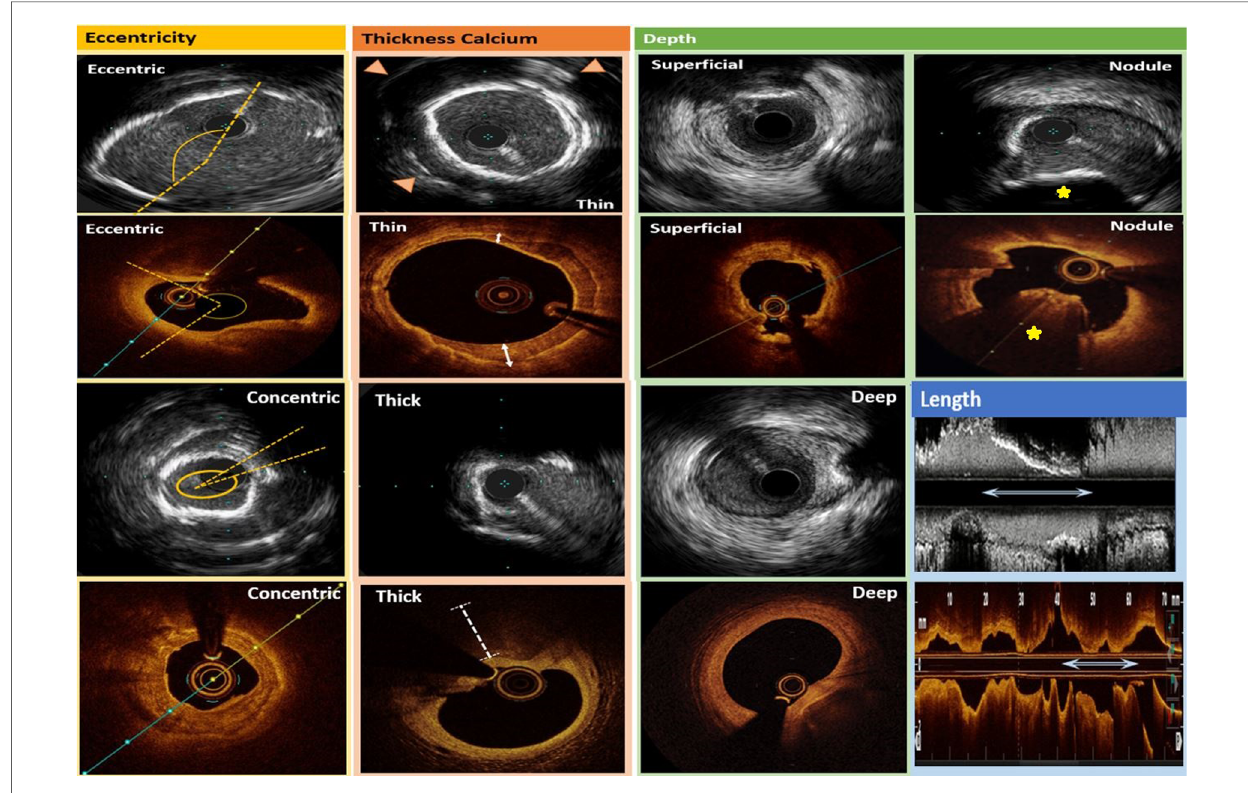
FIGURE 4 Intravascular ultrasound (rows 1 and 3) and optical coherence tomography (rows 2 and 4) calci fi cation pattern summary. In the fi rst column, calcium eccentricity is denoted by the dotted yellows lines which approximate the edges of the calci fi cation. In the second column, thin calcium on IVUS is denoted by the presence of reverberation artifact (arrowheads) whereas thick calcium shows signal drop-out beyond the calci fi cation. Also in the second column, thin calcium on OCT is demonstrated by the sharply delineated plaque with signal attenuation within its borders (bidirectional white arrows), and thick calcium on OCT is demonstrated by the white dotted line which shows signal drop-out beyond the calcium. In the third column, super fi cial and deep calcium intraluminal to the media or extraluminal to the media, respectively, can be visualized on IVUS and OCT. Lastly, in the fourth column, calci fi ed nodules are denoted as yellow stars, and calcium length is illustrated by longitudinal bidirectional white arrows in both the IVUS and OCT